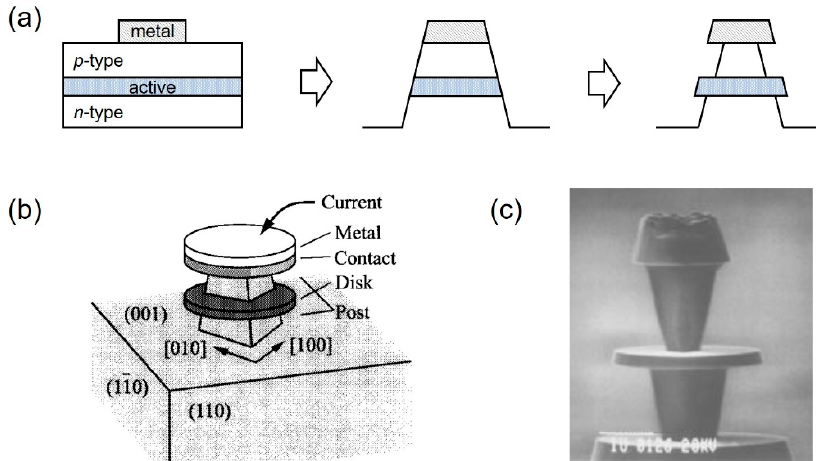
Figure 1. Current injection microdisk lasers: ( a ) Schematics of the key fabrication steps for an injection microdisk structure; electron-beam lithographic definition of circular metal masks on a vertically p - i - n -doped semiconductor wafer where the active medium is included in the middle (left); formation of circular mesas with tilted sidewalls after applying chemically assisted dry etching (middle); and final microdisk structure with asymmetric n - and p -type posts after the wet etching process. ( b ) Schematic of InGaAsP microdisk injection laser. The microdisk is supported by top and bottom InP posts connected to the top Ti/Au contact and bottom p -type InP substrate [13]. Figure reproduced with permission from the Institute of Electrical and Electronics Engineers. ( c ) SEM image of the fabricated injection microdisk laser [12]. Figure reproduced with permission from the Institute of Electrical and Electronics